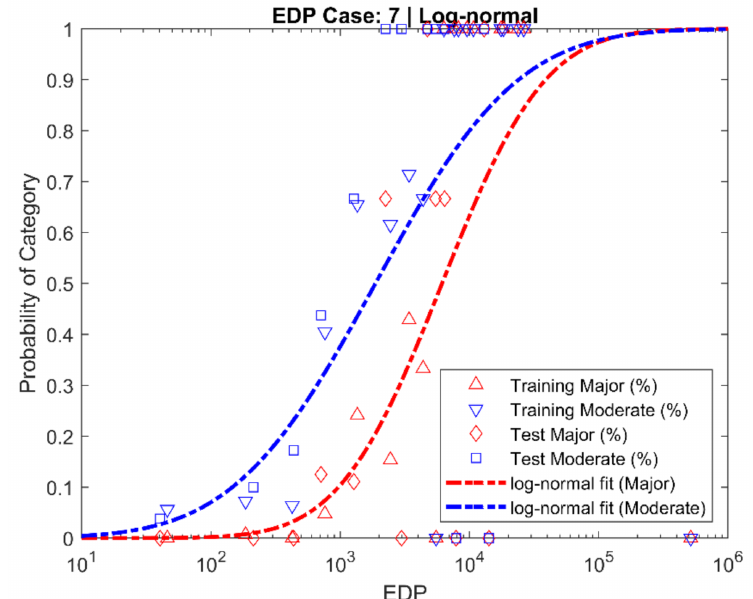
Figure 10. Example log-normal distribution for EDP 7 for calibration/training (triangular shapes) and test datasets (square/diamond). Dashed curves represent MLE log-normal fit curves with red denoting Major and blue denoting Moderate